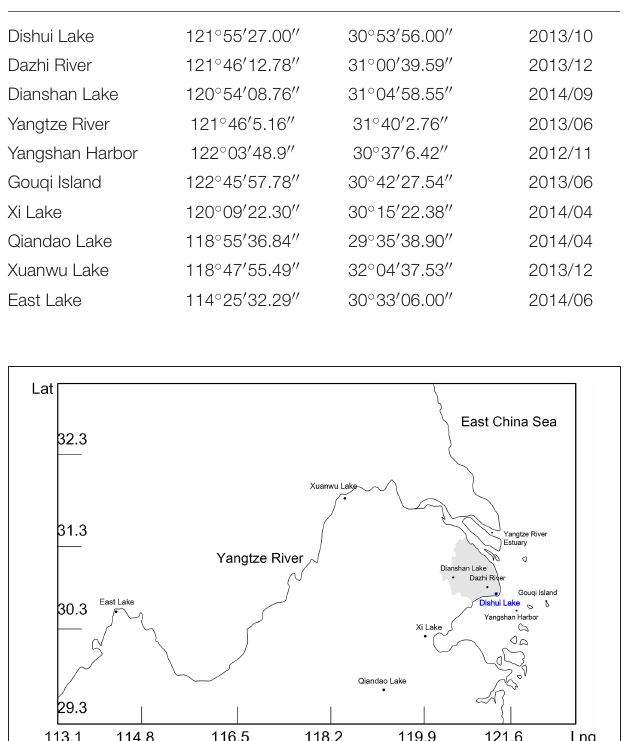
TABLE 1 | The sampling sites and time. Sampling site